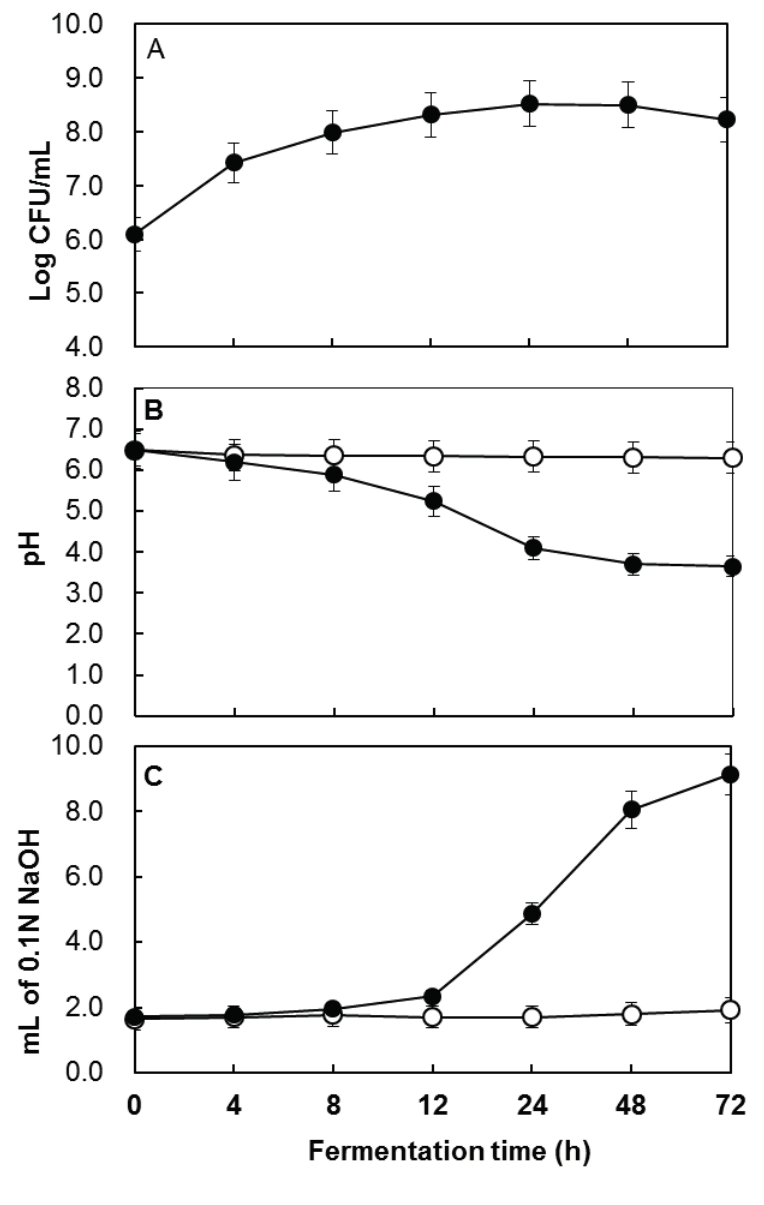
Figure 1. Growth ( A ); pH ( B ), and titrable acidity ( C ) curves during the fermentation of M . denudata extract by P. acidilactici KCCM 11614 at 30 °C for 72 h. ○ , Non fermented (control); ● ,